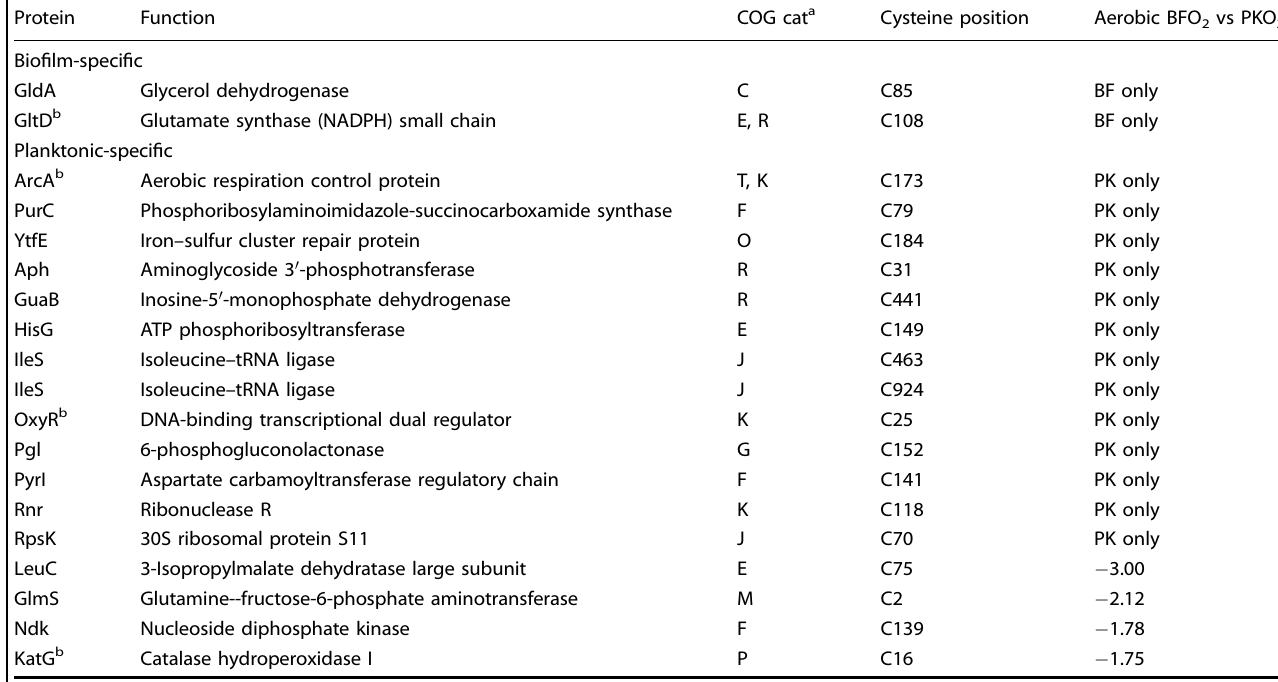
Table 2. List of cysteine residues identi fi ed to be differentially S -nitrosylated in aerobically grown bio fi lm vs planktonic E. coli cultures by using the biotin-switch SILAC